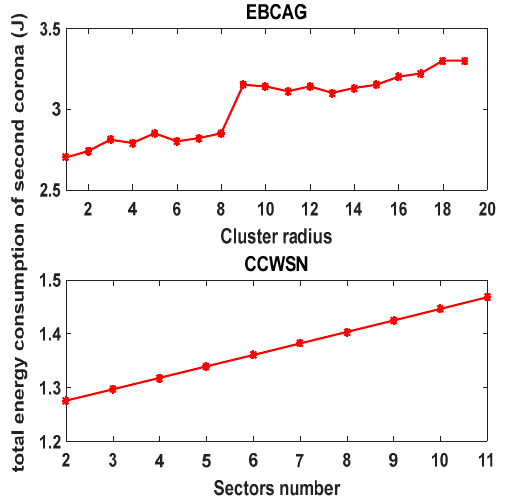
Figure 7. Total energy consumption of the second corona.